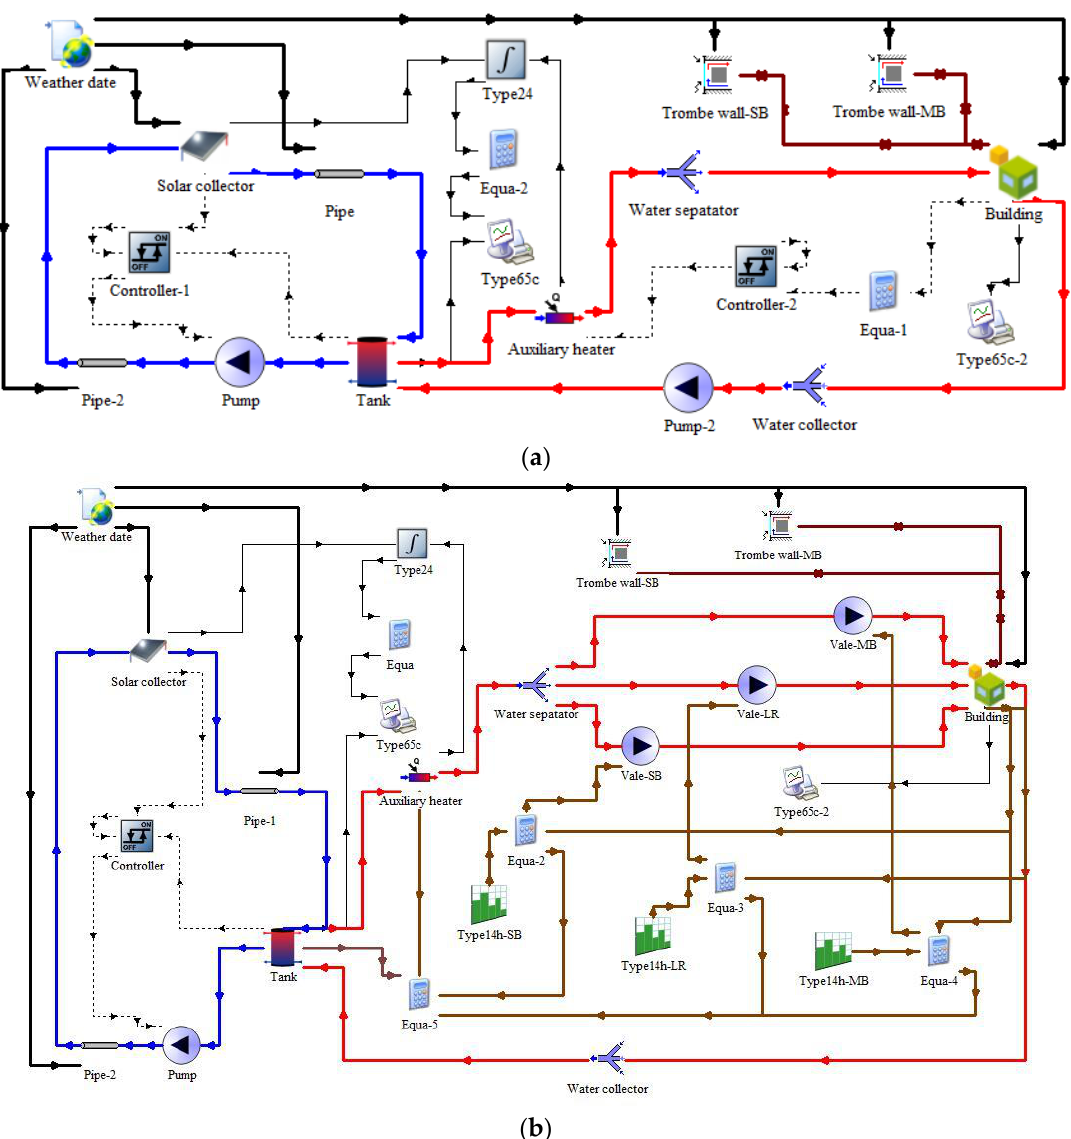
Figure 4. TRNSYS modeling of the SWHS with the two modes: ( a ) CWSH; ( b )